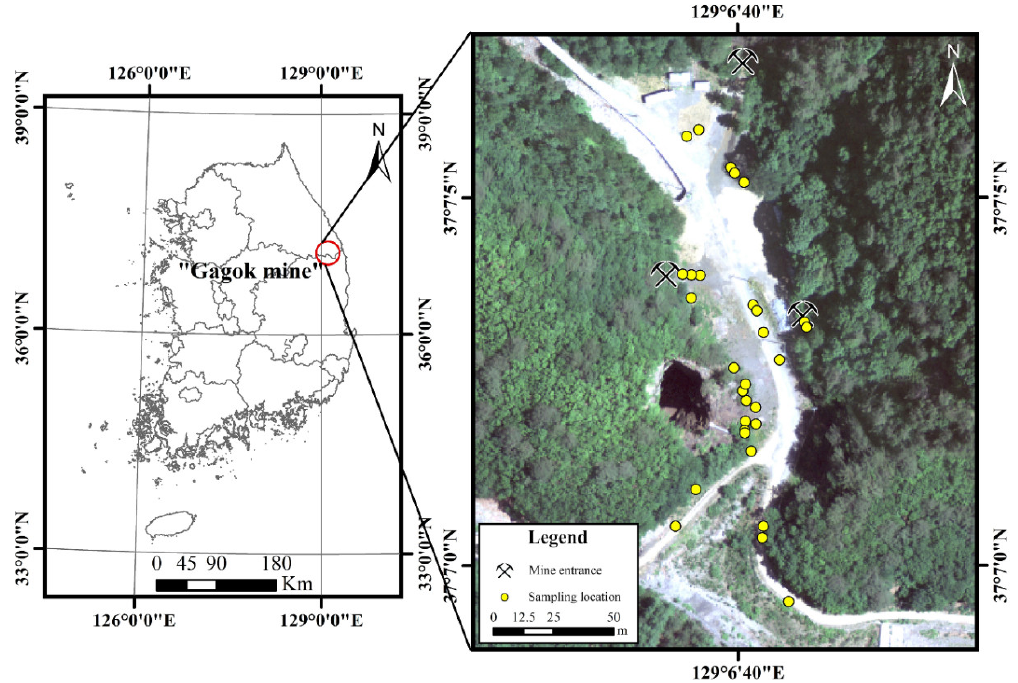
Figure 1. Location map and sampling location of Gagok mine, South Korea.